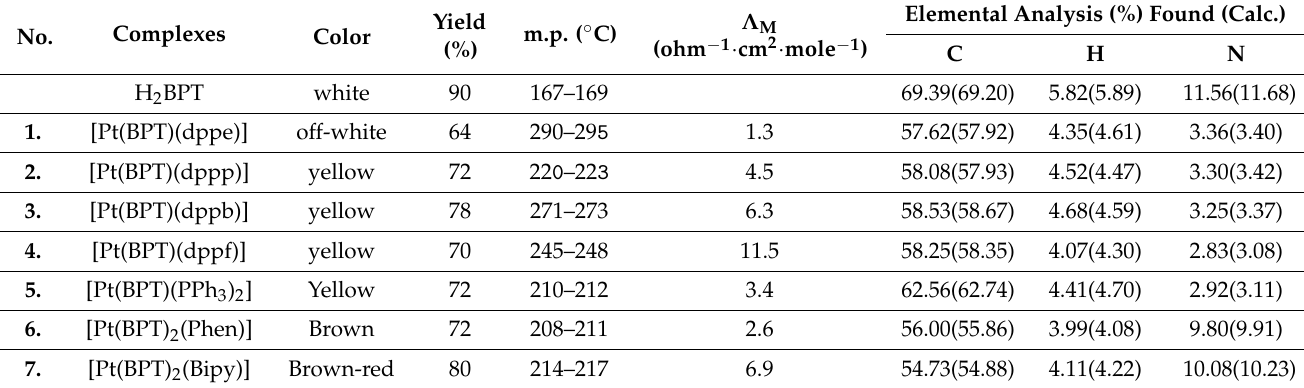
Table 1. Melting point (m.p., ◦ C), yield (%), color, conductivity, and CHN analysis of the H 2 BPT ligand and its